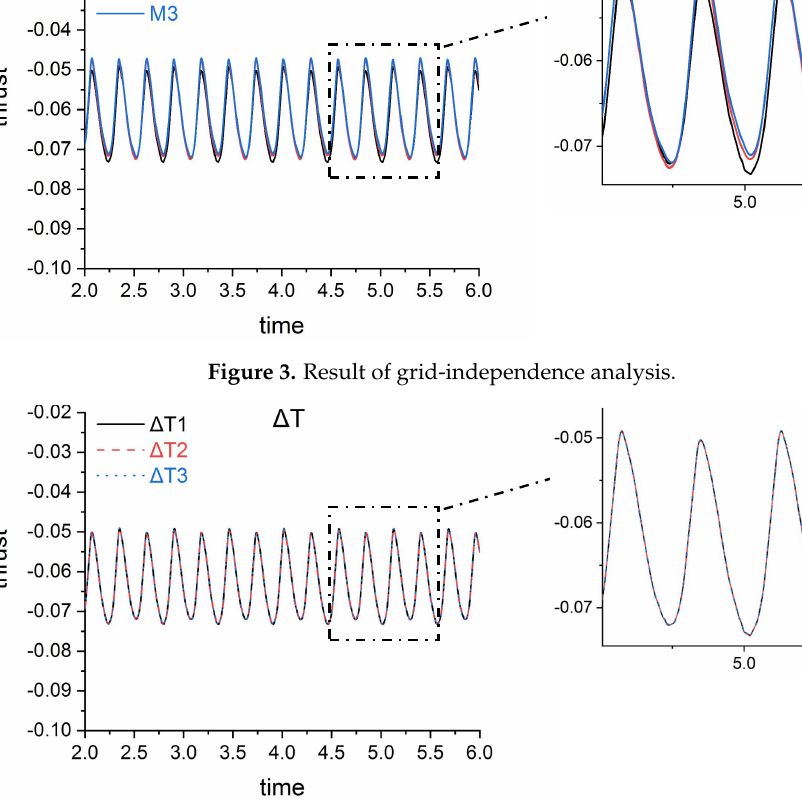
Figure 4. Result of time-independence analysis.